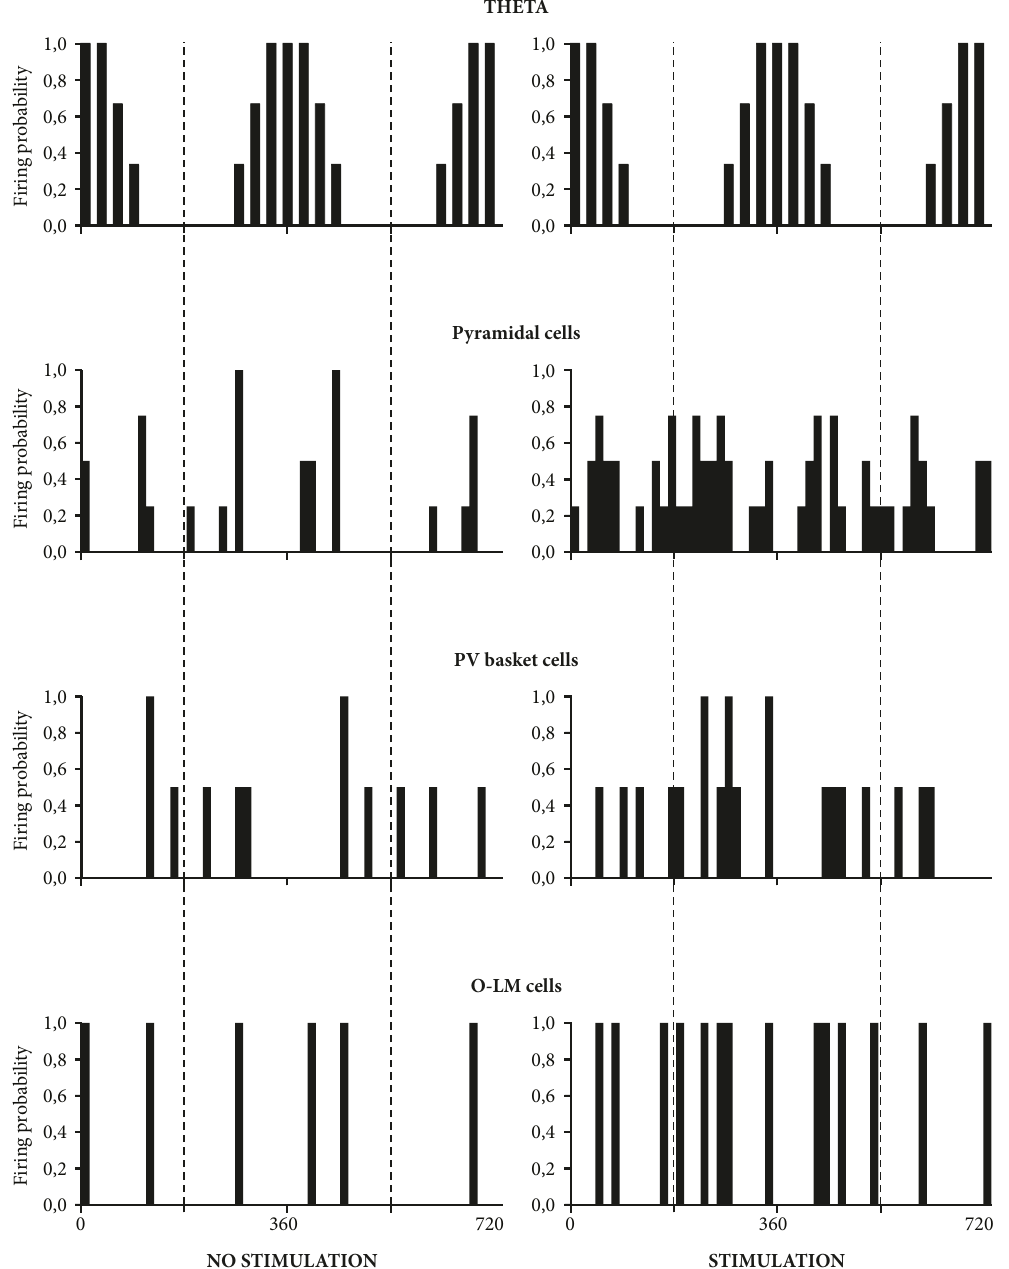
Figure 4: Temporal relationship between theta oscillations, pyramidal cells, basket cells, and OL-M cell. On the left, temporal relationship without LTP inducing protocol. On the right, temporal relationship with LTP inducing protocol. Histograms show the firing probability rates of all cells CA1